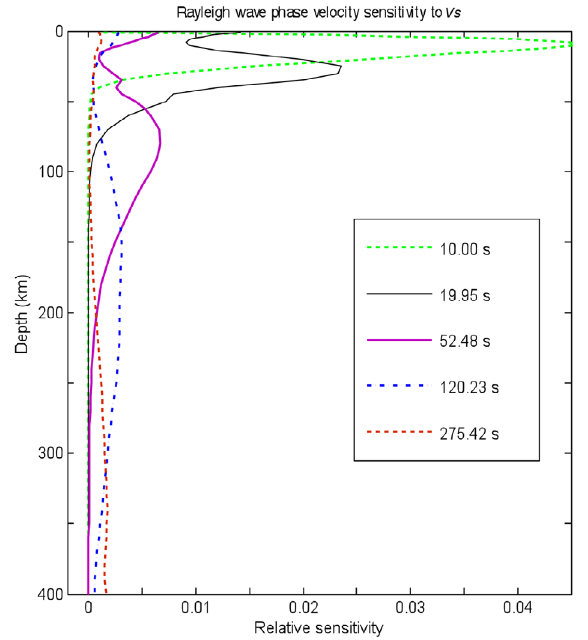
Figure 6. Relative sensitivity of phase velocity ( c ) of Rayleigh waves ) versus depth of the accepted model (Table to P -wave velocity ( V P 5) at various representative periods. The sensitivity shows partial derivatives ∂ c / ∂ V in a layer of 1 km centered at the given depth. P